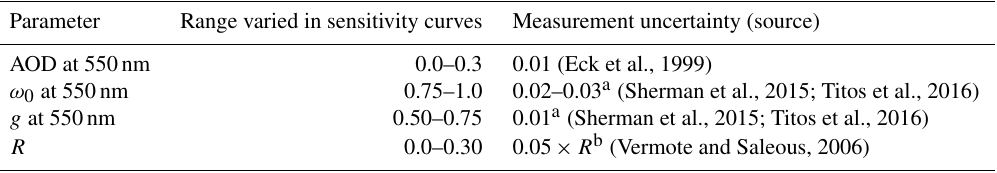
Table 2. Range over which aerosol optical properties and spectrally-averaged surface reflectance used to calculate DRE sensitivities are varied, along with the measurement uncertainties used in the DRE uncertainty